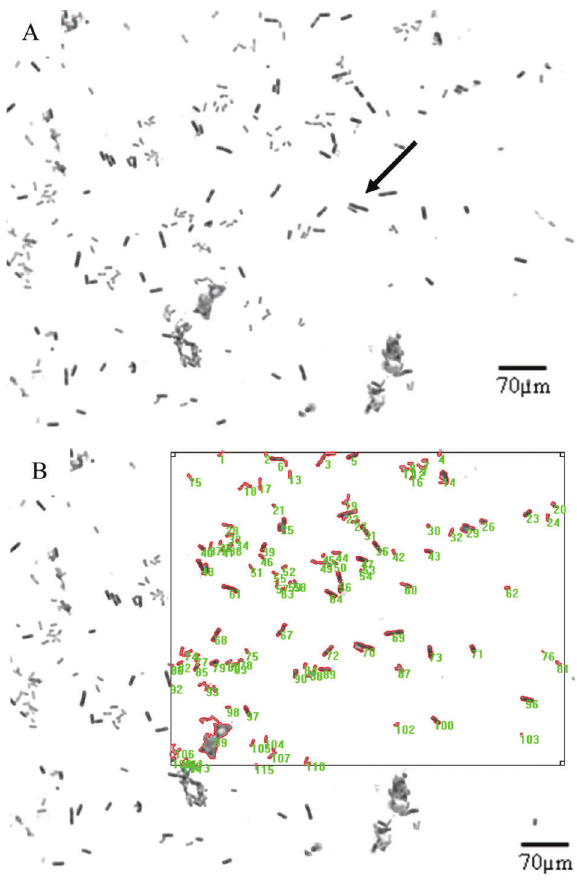
Figure 1. Representative images of bacterial fi lamentation from AB1157 cultures in the stationary growth phase. A , Arrow denotes bacterial fi lamentation; B , same image illustrating how the image analysis was performed. A bacterial fi lament was considered to be present in a bacterium when the area of the bacterial cell was 2.5-times larger than the mean value of the